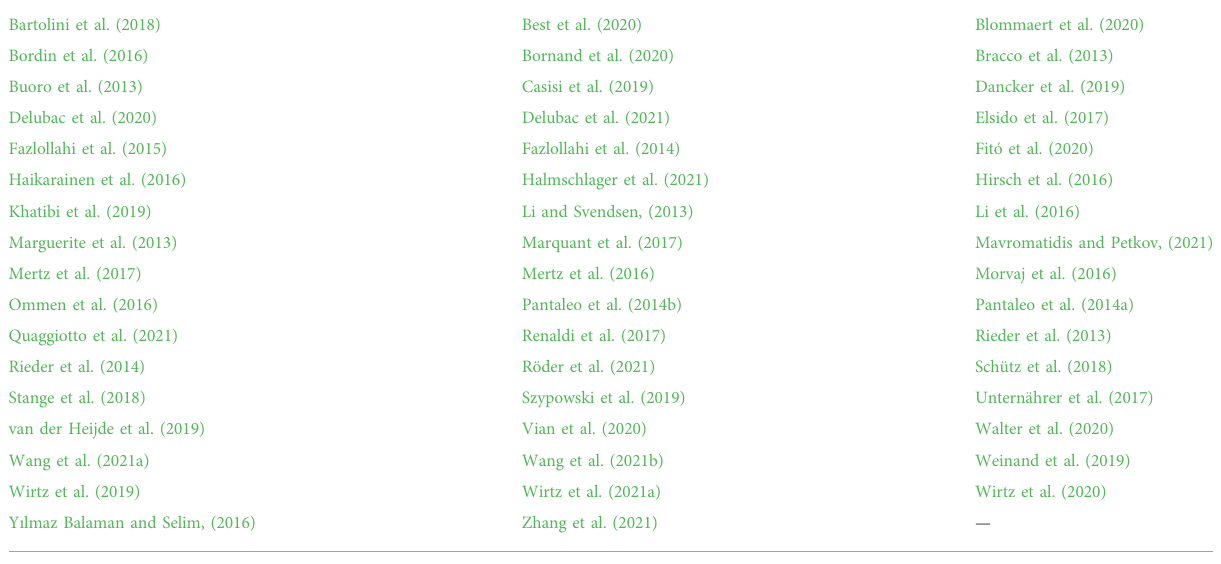
TABLE 1 Publications from the SLR for the literature distribution.